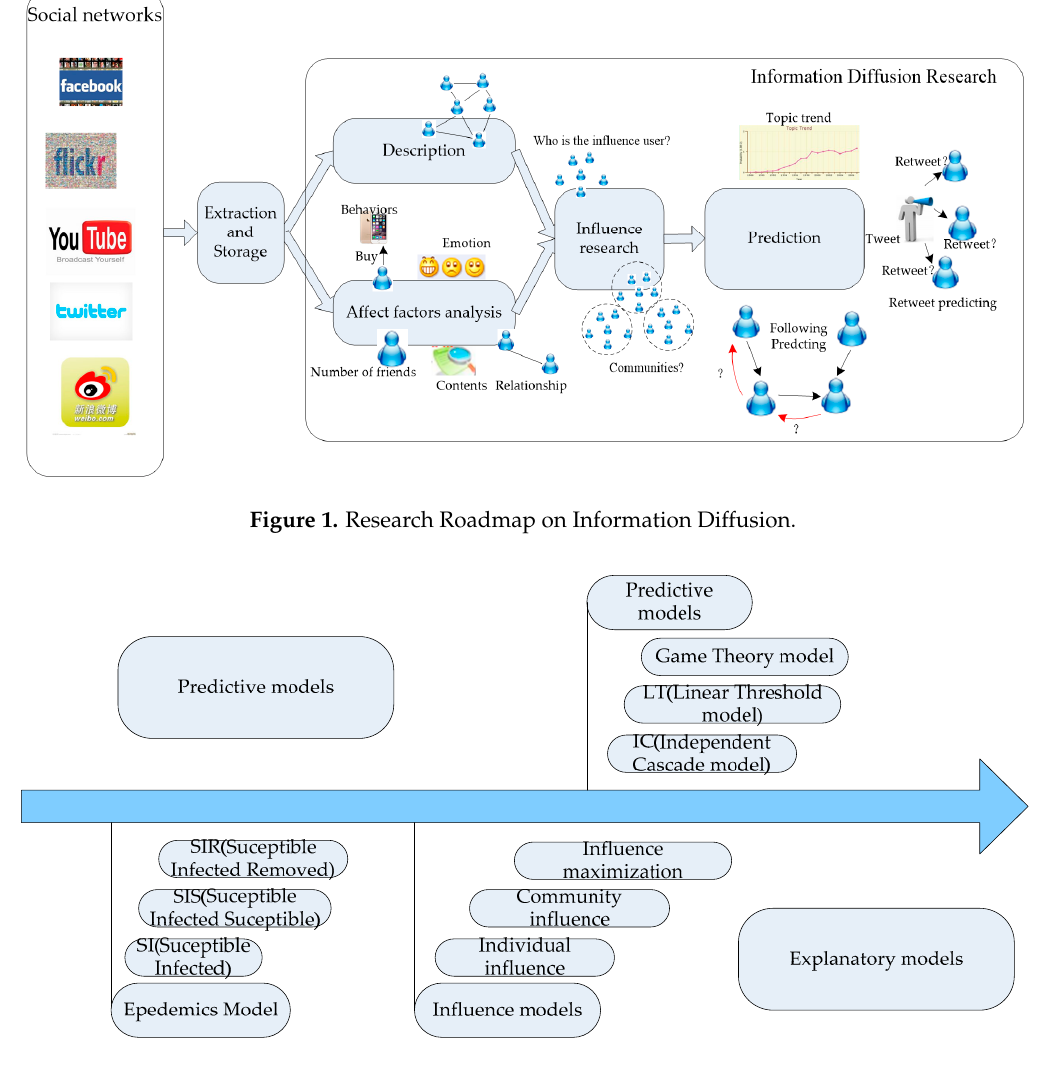
Figure 2. Categorization of Information Diffusion